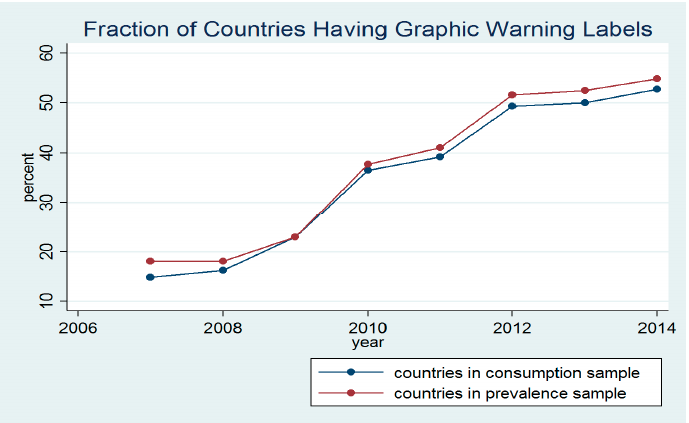
Figure 1. The fraction of countries having graphic warning labels (GWLs) during the study period (2007–2014) in the smoking prevalence and cigarette consumption samples.